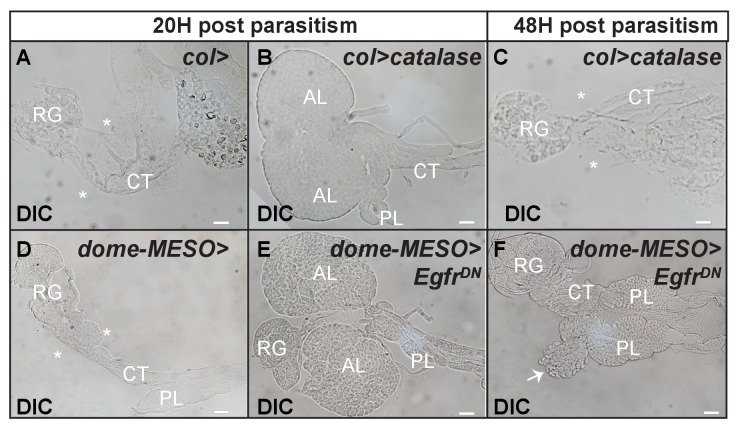
Scavenging ROS in PSC cells or silencing the EGFR pathway in MZ progenitors delays lymph gland disruption upon parasitism.Differential interference contrast (DIC) microscopy of lymph glands 20 hr (A, B, D, E) and 48 hr (C, F) post parasitism in control (A, D) and when Catalase is expressed in the PSC (col > catalase) (B, C) or when the EGFR pathway is inactivated in lymph gland progenitors (dome-MESO > EgfrDN) (E, F). Ring gland, RG; cardiac tube, CT; anterior lobe, AL; posterior lobe, PL; disrupted (*) and disrupting (arrow in F) anterior lobes are shown. The scale bar represents 20 µm. All source data are supplied as Excel files.